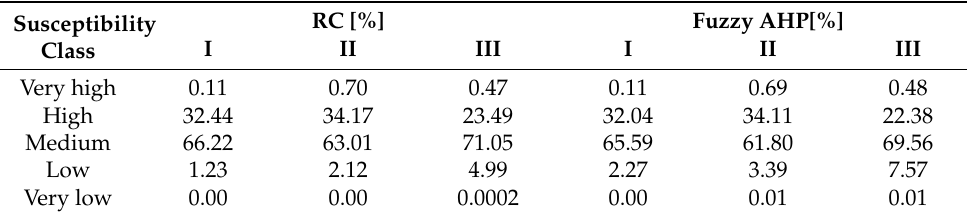
Table 9. Share of forest fire susceptibility zones in total area of different regimes of protection.